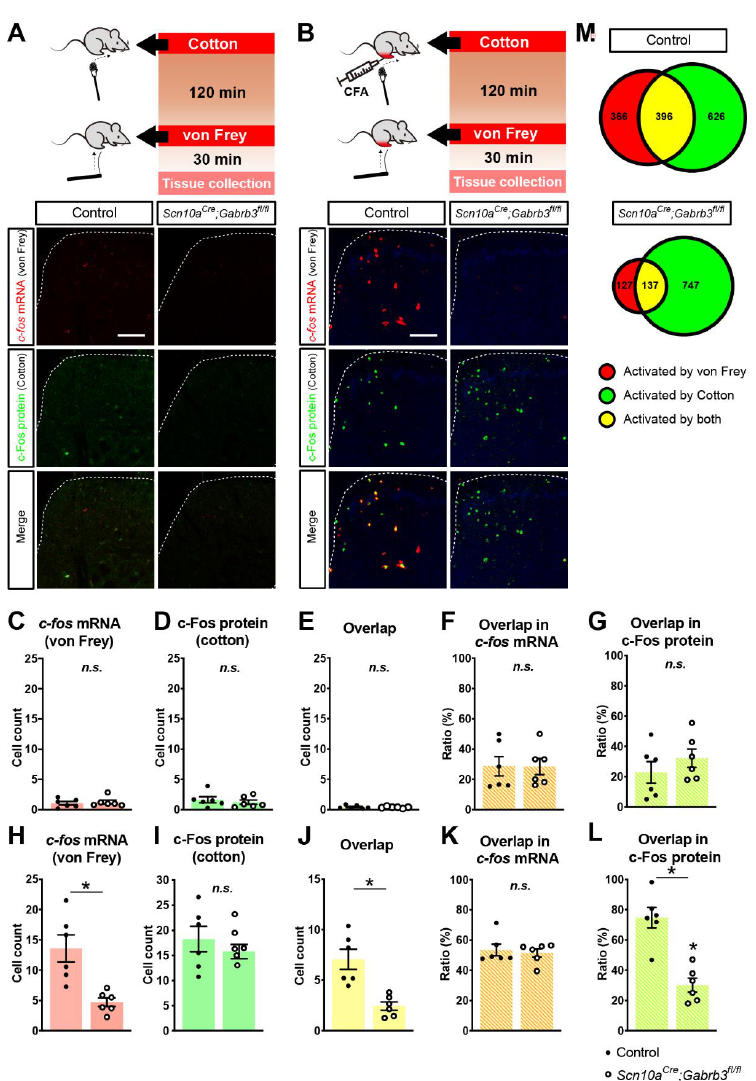
Figure 4. ( A ) Dual labelling of c-fos mRNA (red, ( A )) and c-Fos protein (green, ( A )) in spinal dorsal horn showed cells activated either by dynamic (cotton, ( A )) or punctate mechanical stimulation (von Frey, ( A )) or both (overlap, yellow, ( A )) in littermate controls (left, ( A , B )) and Scn10a Cre ; Gabrb3 fl/fl mice (right, ( A , B )) before CFA. ( B ) Two days after CFA injection, the number of cells responding to dynamic (c-Fos, green, ( B )) and punctate ( c-fos , red, ( B )) mechanical stimulation increased and there was also an accompanying increase in the number of cells activated by both forms of mechanical stimuli after CFA (yellow, ( B )). ( C – L ) pooled data showing cell counts per mouse (averaged from at least 3 sections) for Scn10a Cre ; Gabrb3 fl/fl mice (open markers) and littermates (closed markers) prior to CFA ( C – G ) and 2 days after CFA ( H – L ). Average cell counts per mouse are shown in response to punctate (von Frey, ( C , H )), dynamic (cotton, ( D , I )), and both forms of mechanical stimulation (overlap, yellow, ( E , J )). The degree of overlap is shown as the percentage of cells responding to dynamic stimulation (c-Fos) as a fraction of those responding to punctate stimulation (overlap in c-fos , orange, ( F , K )) as well as the percentage fraction of cells responding to punctate stimulation ( c-fos ) amongst those responding to dynamic stimulation (overlap in c-Fos, light green, ( G , L )). ( M ) Venn diagram depiction of the overlap of c-fos + cells responding to punctate (red, ( M )), c-Fos + cells responding to dynamic mechanical stimulation (green, ( M )) and their overlap (yellow, ( M )) for littermate controls (upper, ( M )) and Scn10a Cre ; Gabrb3 fl/fl mice (lower, ( M )) 2 days after CFA injection. Data represent averages of 12–15 coronal slices per mouse from lumbar (L3–L5) spinal dorsal horn using 6 mice per group. Values of p < 0.05 were considered significant and are indicated with asterisks as follows; * p < 0.05, n.s. = not